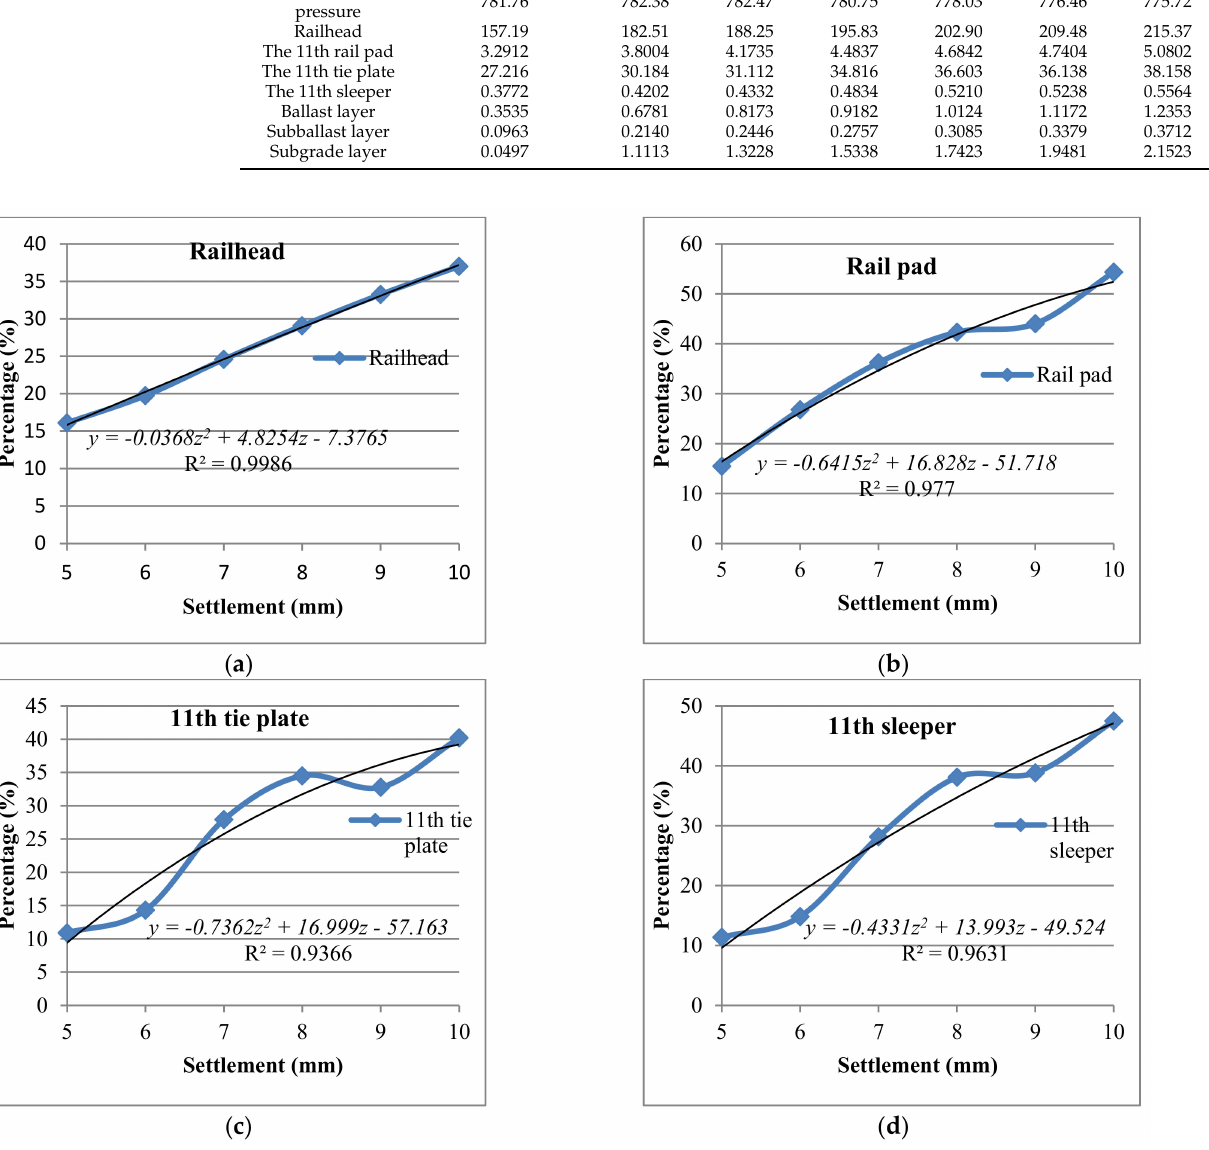
Table 5. Stress values of railway track elements in states with and without settlement. Element without Settlement